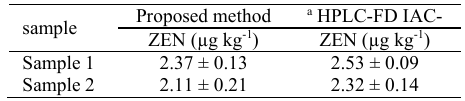
Table 4. Comparison of ZEN analyses (mean ± SD, n=3) in Table 4 contaminated wheat samples by the proposed and standard Comparison of ZEN analyses (mean ± SD, n=3) in contaminated wheat samples by the proposed and standard IAC-HPLC-FD method. IAC-HPLC-FD method.